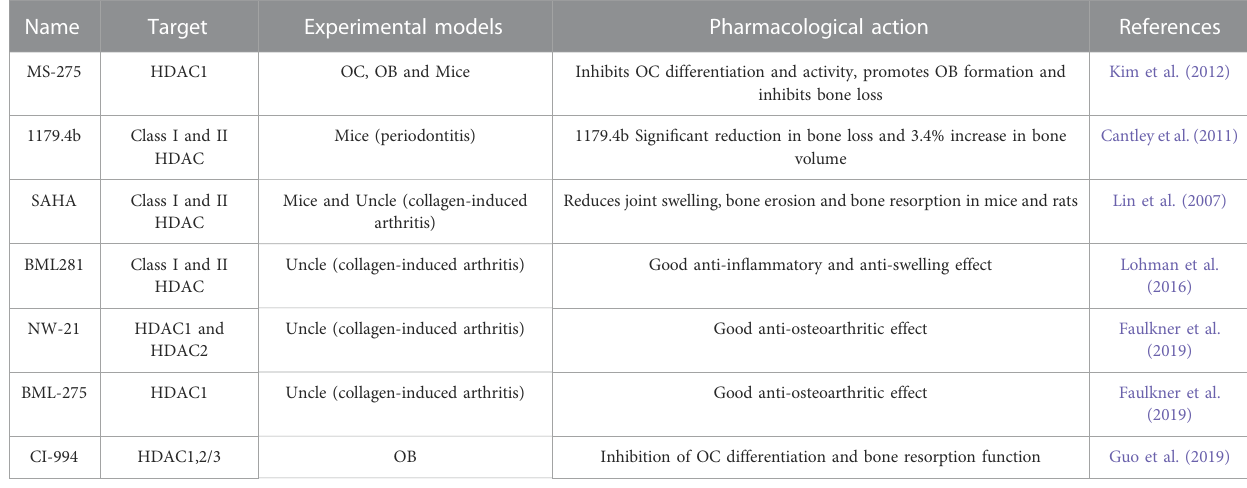
TABLE 1 HADCi and OC